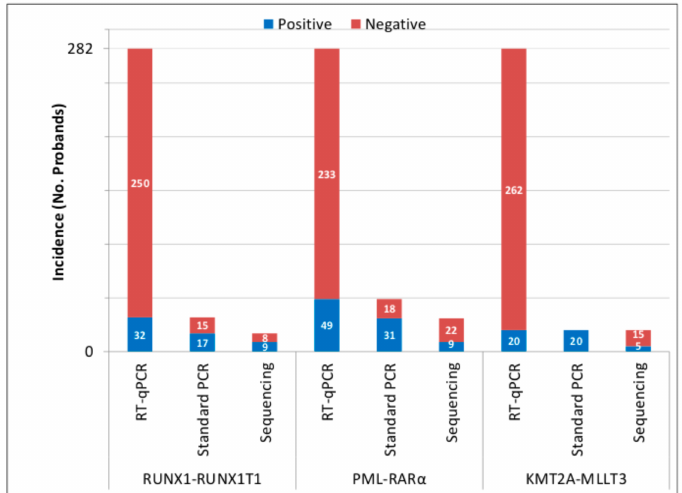
Figure 1. Incidence of acute myeloid leukemia (AML) preleukemic fusion genes (PFGs) in umbilical cord blood (UCB) of Slovak newborns. The figure shows the number of PFG negative and posi- tive samples detected by real time quantitative PCR (RT-qPCR) and validated by standard PCR and